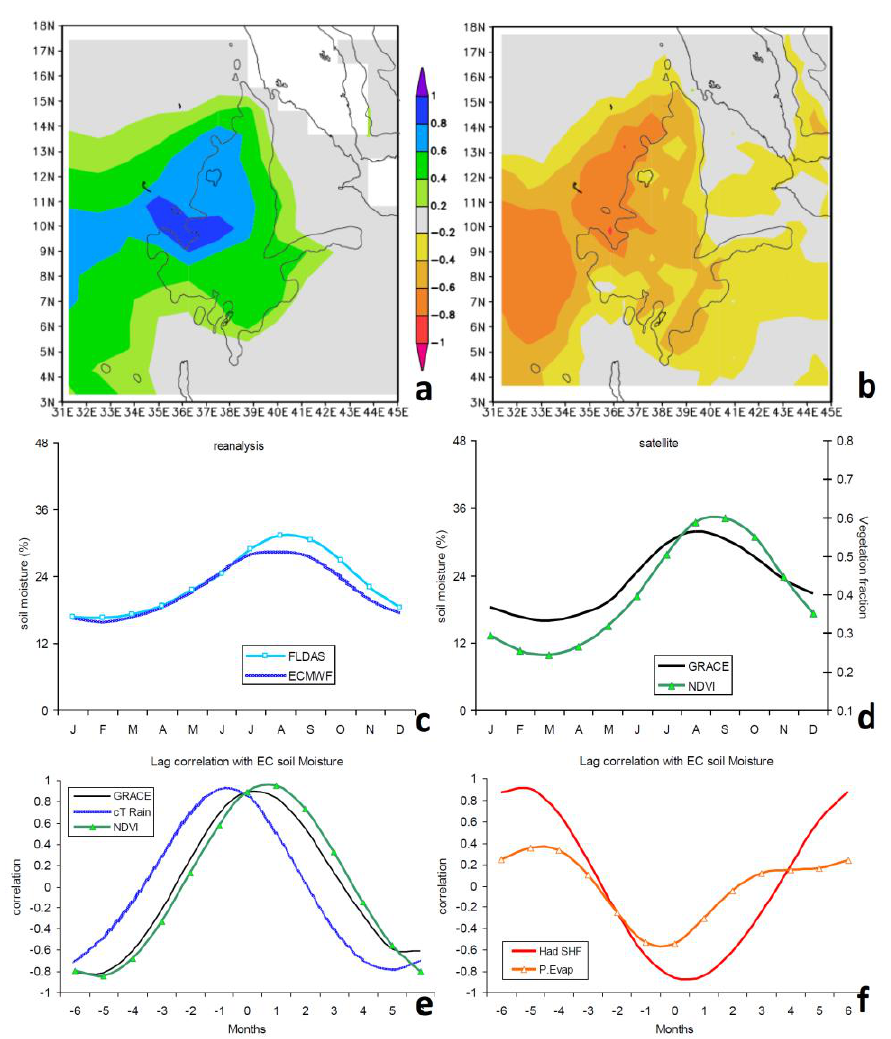
Figure 5. EOF loading patterns of 1st mode ECMWF reanalysis: ( a ) S and ( b ) SHF, identifying zones with unimodal climate. Mean annual cycle of area-averaged: ( c ) reanalysis S and ( d ) satellite S and vegetation NDVI. Lag-correlation of reanalysis S with variables from the NW Ethiopia area: ( e ) cenTrends P, satellite S and NDVI, and ( f ) Hadley2-rcp6 SHF and ECMWF E. Negative months refer to variable leading S.